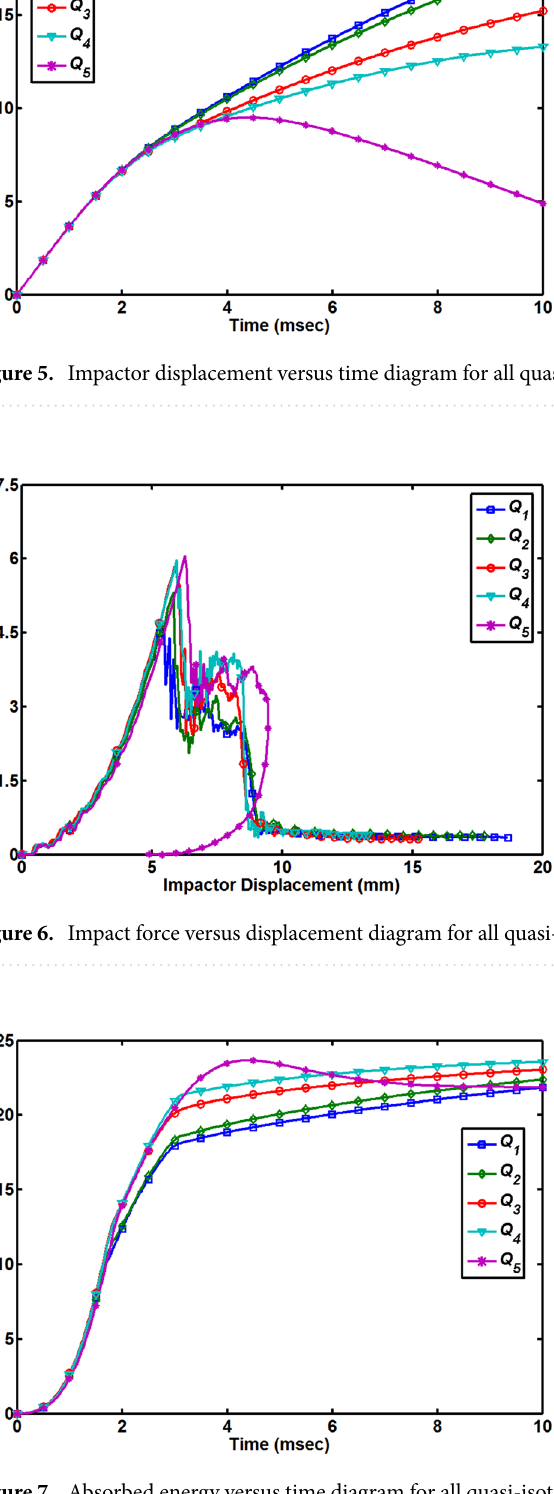
Figure 7. Absorbed energy versus time diagram for all quasi-isotropic composite